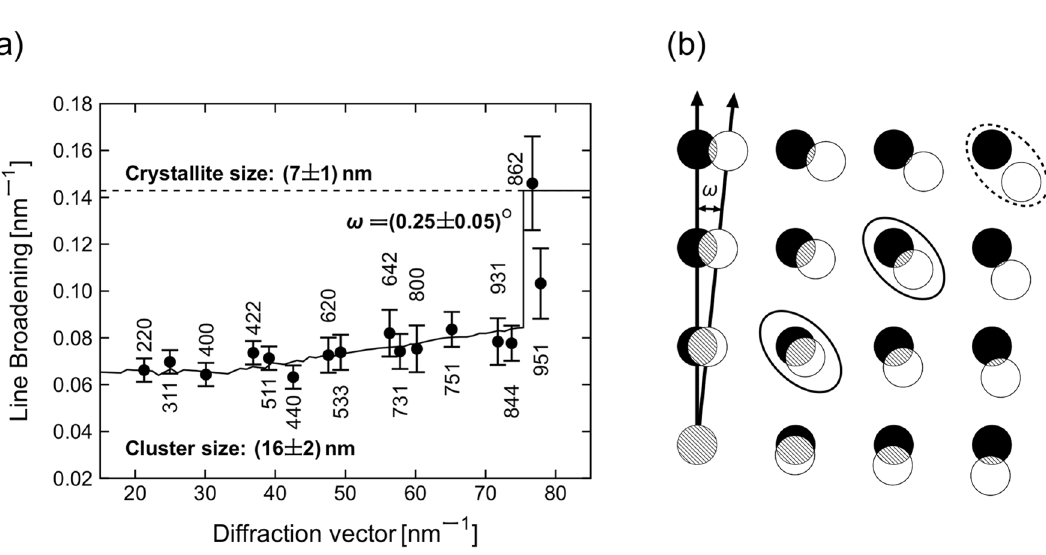
4 π sin θ/ (cid:31) . Black circles represent q q | | ≡ = q calculated for | |